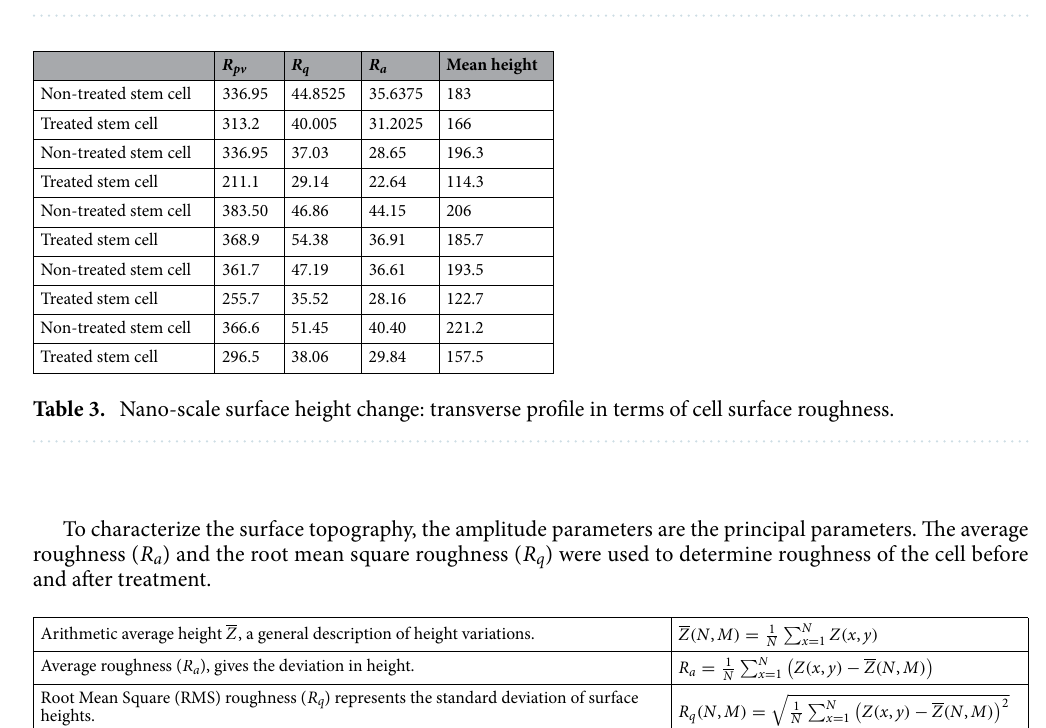
Figure 18. Cell surface roughness, ( a ) before plasma treatment, ( b ) after plasma treatment, ( c ) mean height.